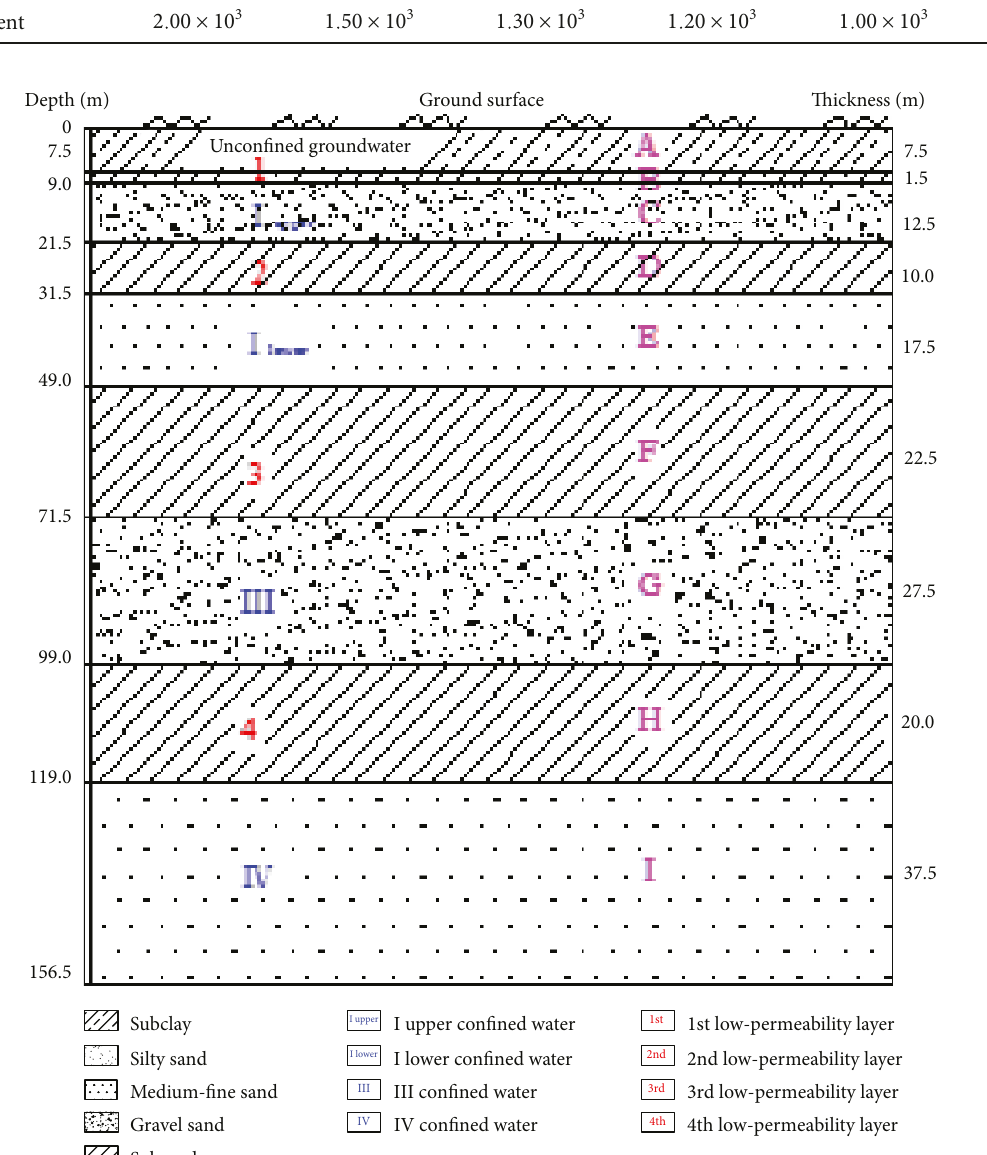
Figure 4: Hydrostratigraphy along the cross-section in the Changzhou